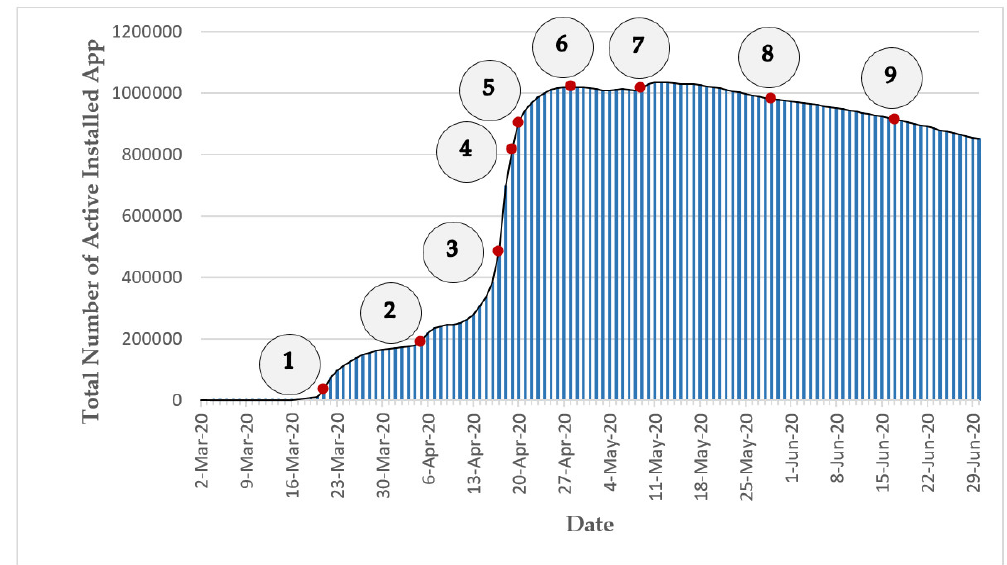
Figure 1. (1) Total number of active installed Mask apps per day (raw data courtesy of Mask project); (2) timeline of the identified television programs broadcasted by IRIB related to the Mask project and the endorsement, recommendation, or promotion of the Mask project by the government (from 2 March to 30 June 2020). Notes: the figures for the total number of active installed Mask apps per day are limited to the installed instances of the Mask app downloaded from Cafe Bazaar Android marketplace; the numbering of the events is the same as that in Table 3.